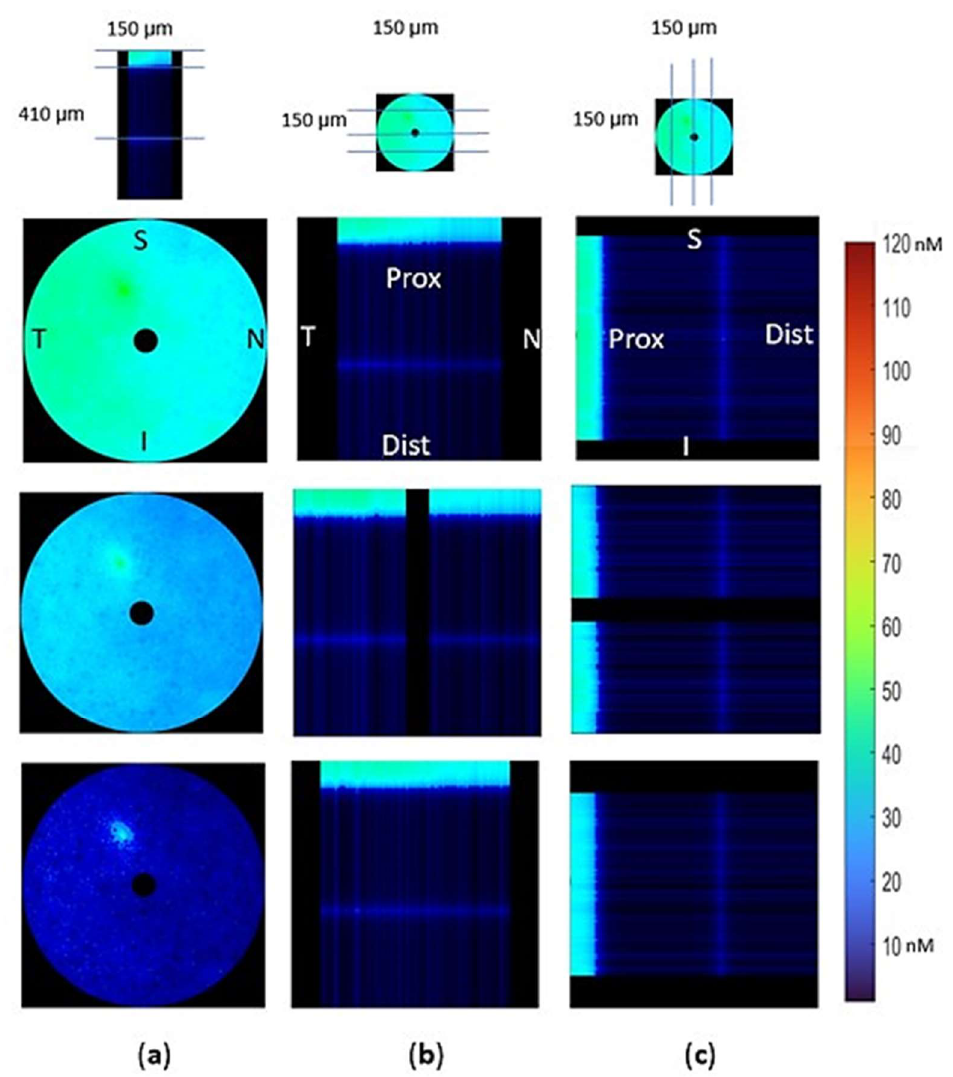
Figure 7. Models with unmyelinated and myelinated regions show distinct [H 2 O 2 ] patterns in the two regions, with higher concentrations of H 2 O 2 in the unmyelinated region (P m = 20 µ m s − 1 , uniform scavenging along the Z axis). The intensity map values are in nM. ( a ) Coronal plane [H 2 O 2 ] map at 3 places along the Z axis; ( b ) Transverse views show large [H 2 O 2 ] differences along the Z axis. ( c ) Sagittal views of [H 2 O 2 ] demonstrate that peak concentrations are in the unmyelinated region, similar to what is seen in the transverse